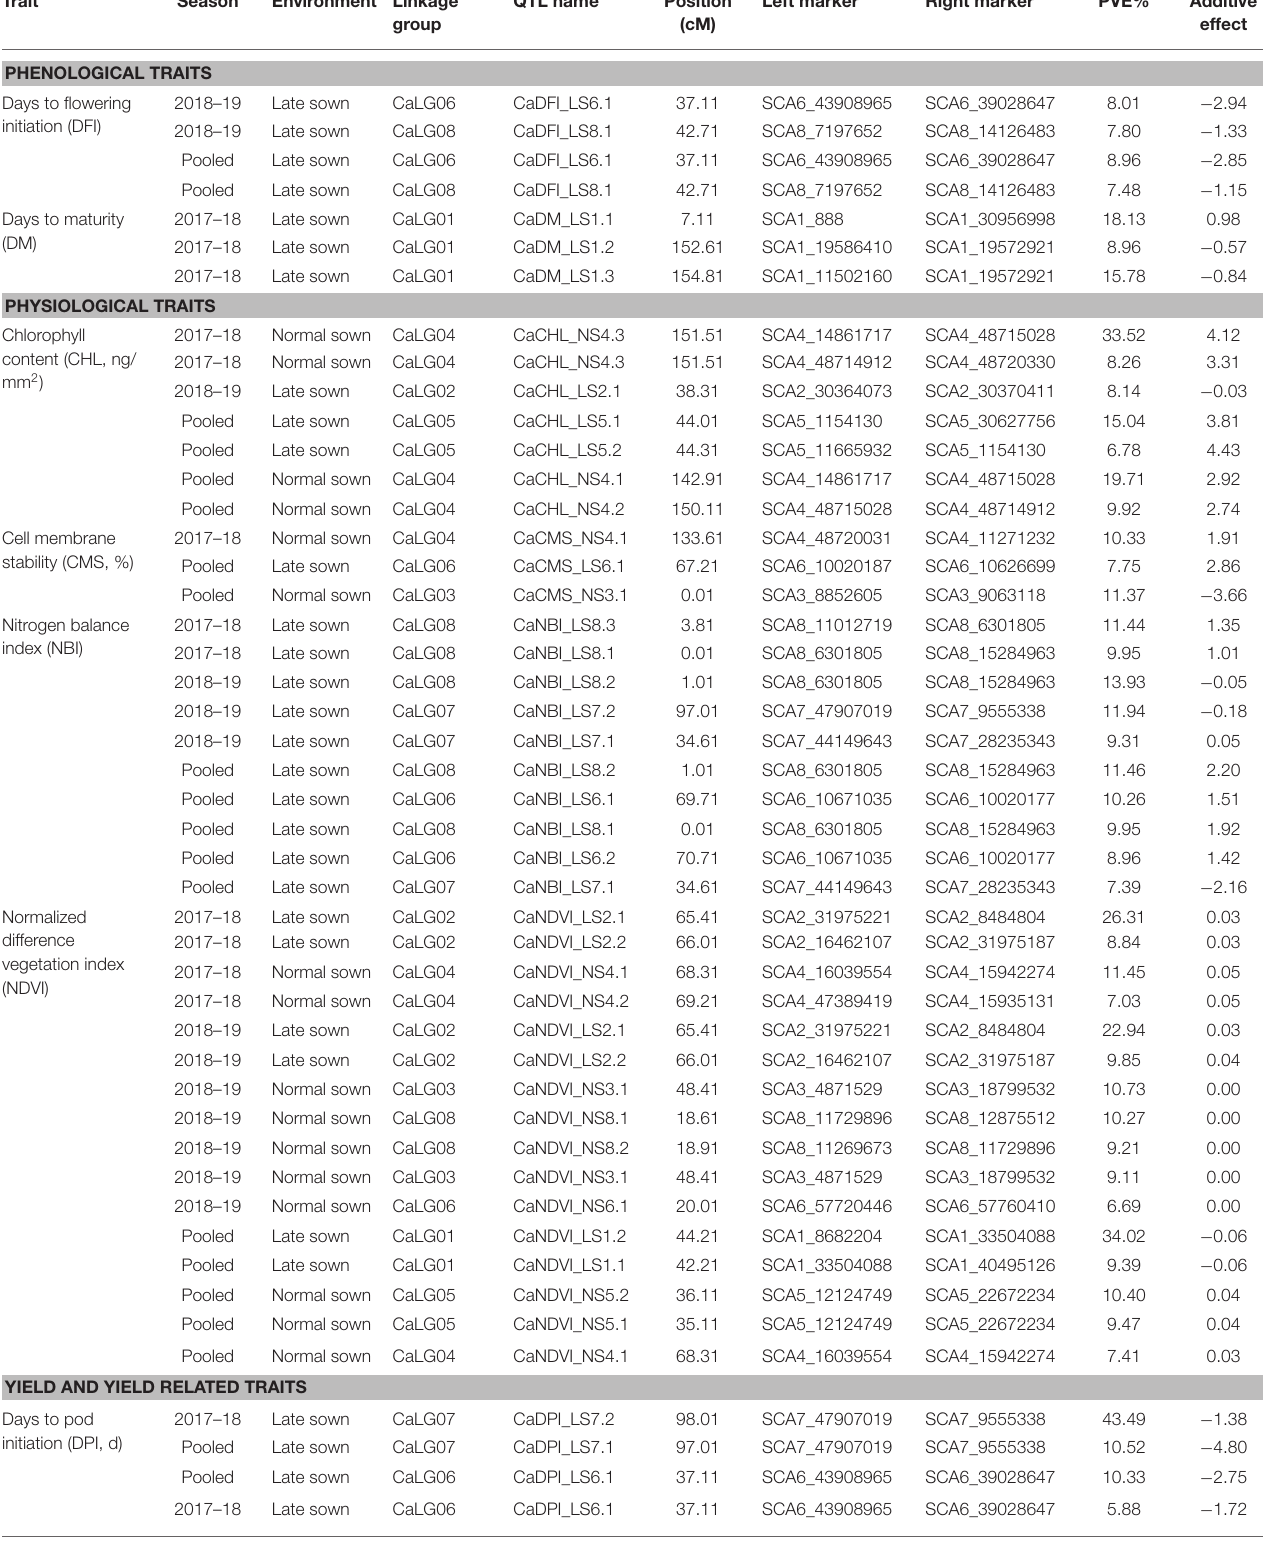
TABLE 2 | Summary of QTLs identified for phenological, physiological, yield, and yield-related traits using RIL population derived from DCP 92-3 × ICCV 92944.